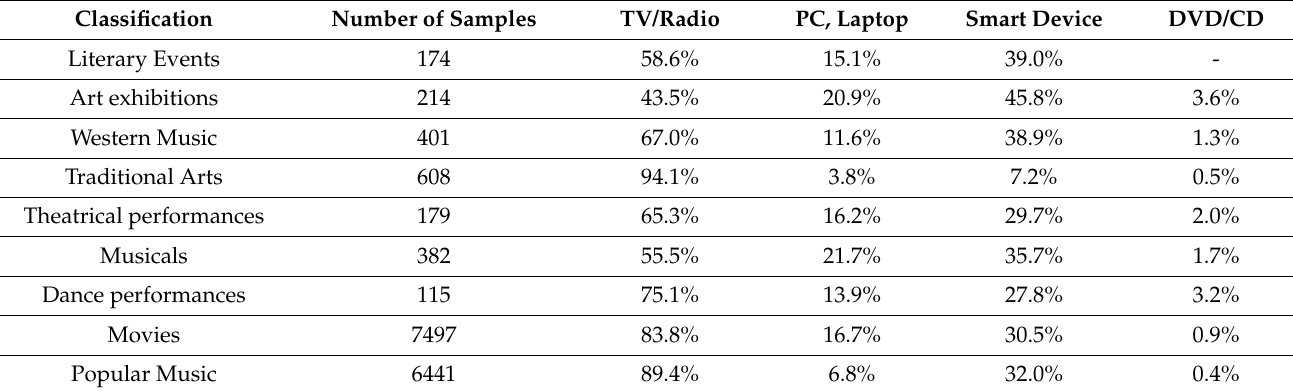
Table 1. Media used to watch cultural and artistic events in 2020. Multiple responses